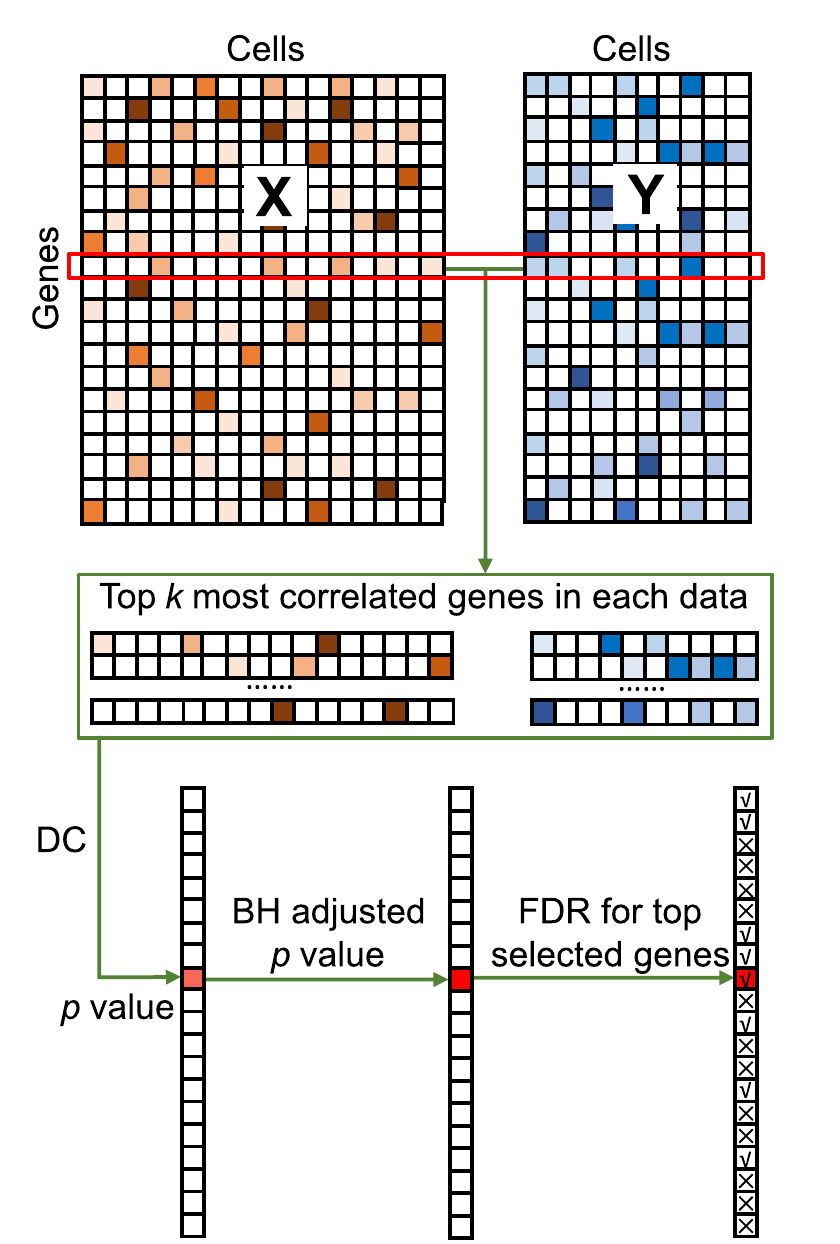
Fig 1. Schematic diagram of ADC. Single-cell gene expression data are used as an example to illustrate ADC. X and Y are data matrices with matched genes as the inputs of ADC. For each target gene, ADC selects k genes having the highest Pearson correlation coefficient with the target one to calculate the p value of DC. After that, ADC performs the BH adjustment to control the FDR and outputs the most highly interrelated genes.